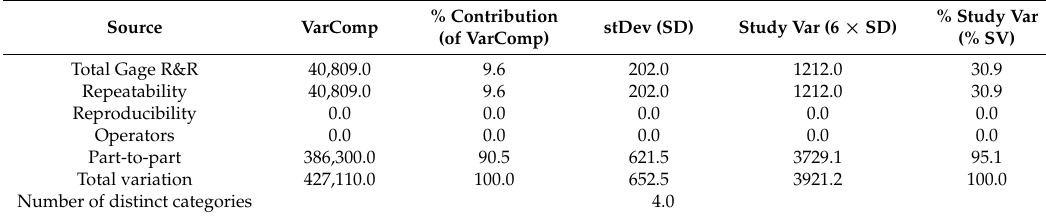
Table 4. Condition 1 Gage R&R for the Q factor.